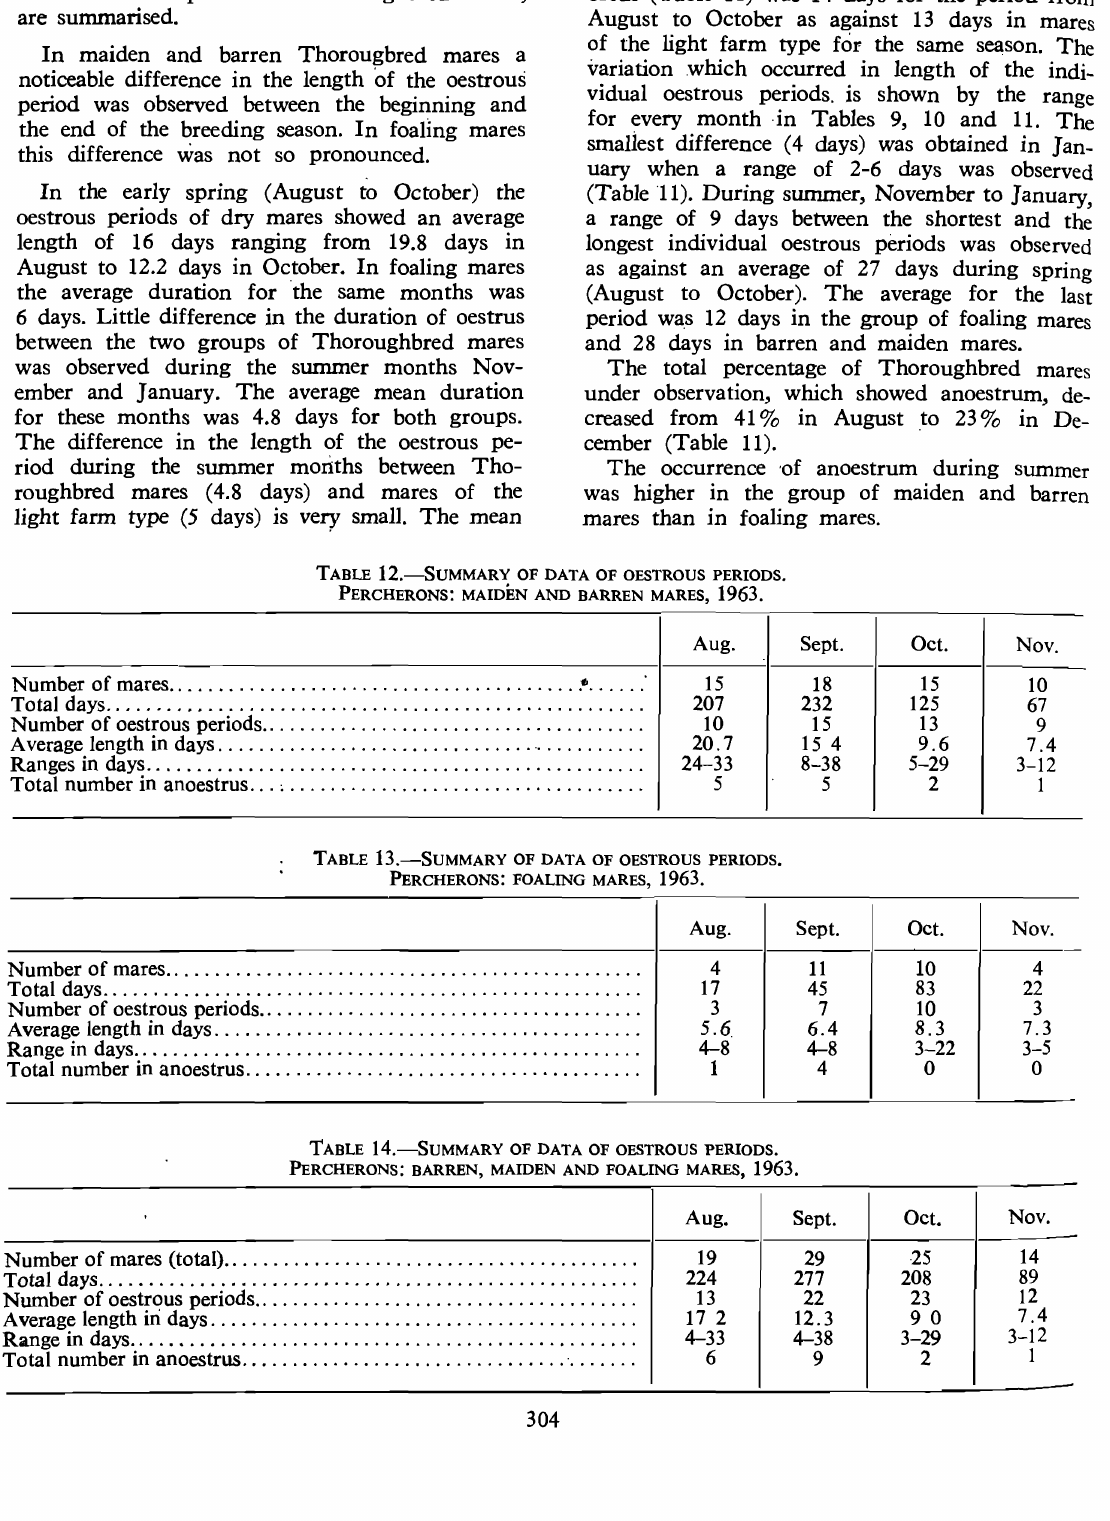
TABLE 14.-SUMMARY OF DATA OF OESTROUS PERIODS. PERCHERONS: BARREN, MAIDEN AND FOALING MARES, 1963.